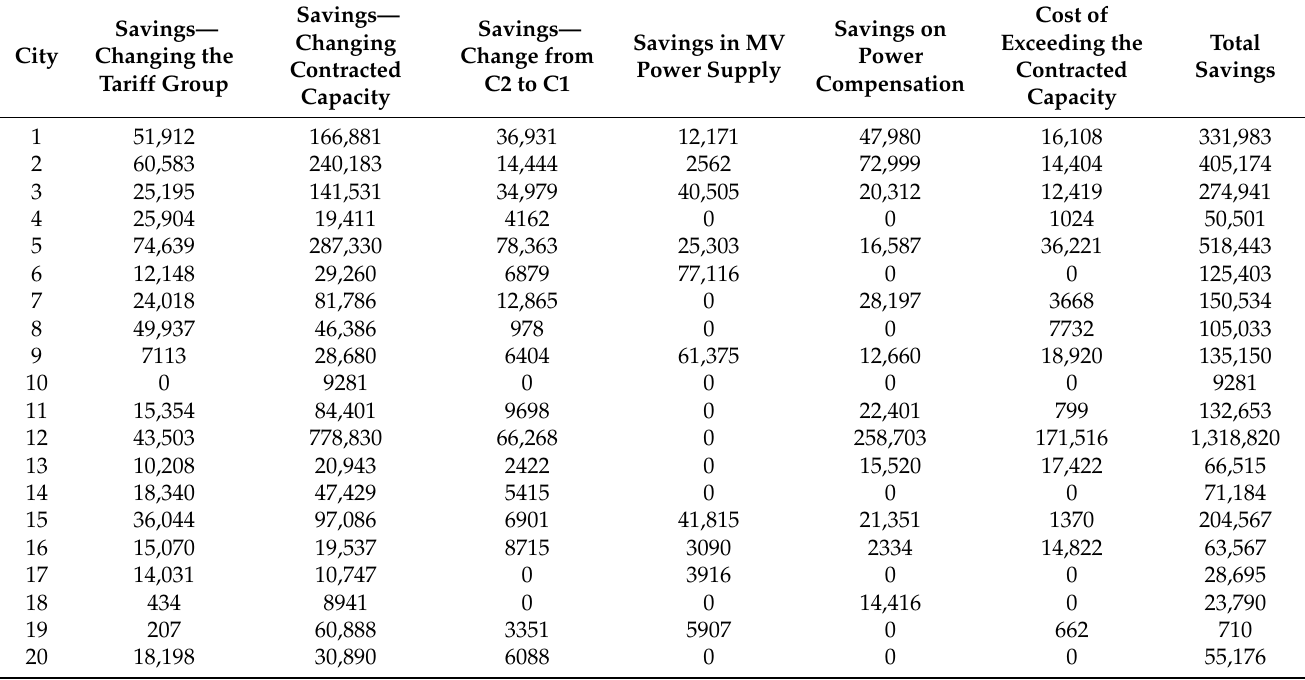
Table 2. Electricity distribution costs analysis—results